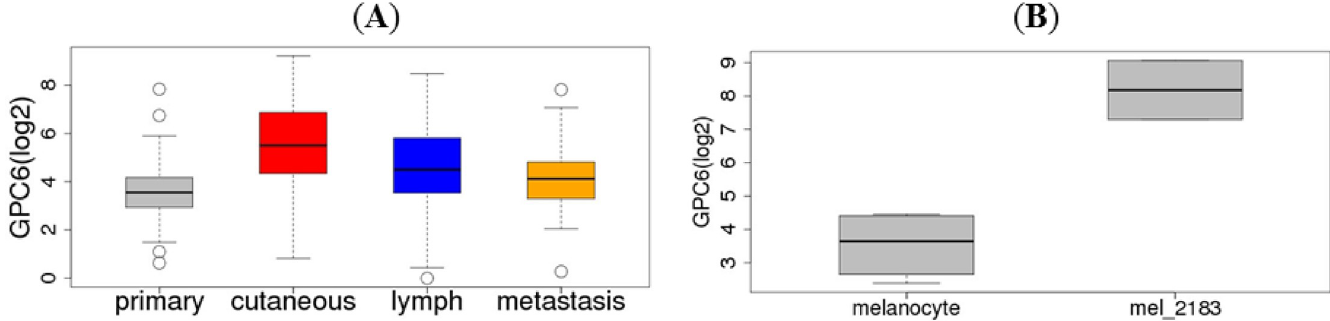
Fig 1. GPC6 expression in normal and melanoma cell lines and TCGA melanoma tumors. Data from the two platforms were not normalized for direct comparison. (A) GPC6 expression in TCGA melanoma samples from four tissue sites (RNA-seq from TCGA). (B) Boxplots of the expression of GPC6 in normal melanocytes (four replicates) and melanoma cell line (mel-2183, two replicates) measured by Affymetrix arrays (GSE15805).